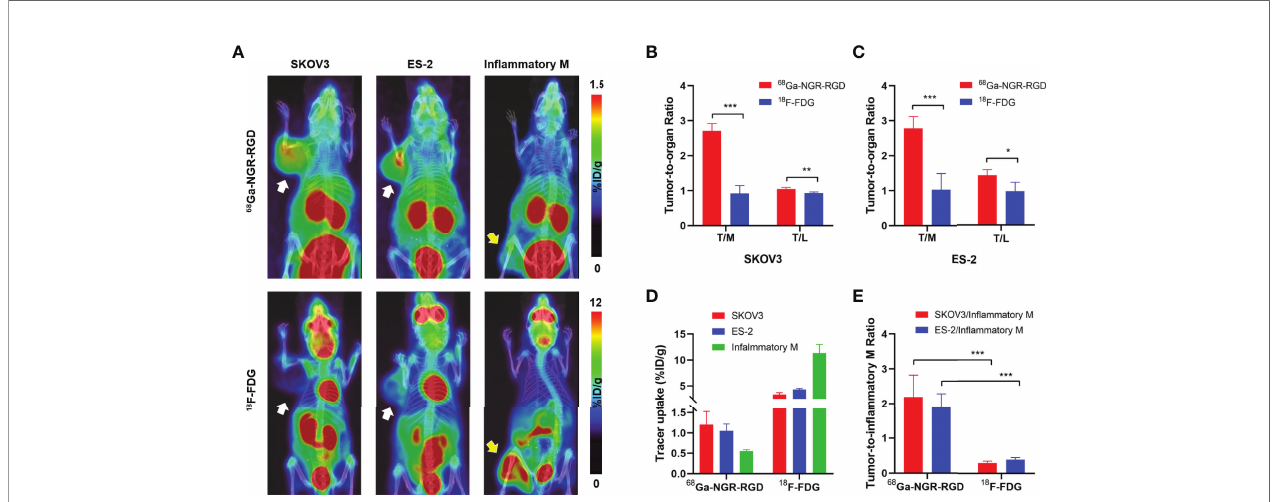
FIGURE 2 | PET/CT imaging and quantitative analysis of 68 Ga-NGR-RGD and 18 F-FDG in subcutaneous ovarian cancer models and in fl ammation models. (A) Representative static small PET/CT images of 68 Ga-NGR-RGD and 18 F-FDG in SKOV3 and ES-2 xenograft mice and turpentine oil-induced muscular in fl ammation mice at 1 h post radiotracer injection. White arrows indicated tumors and yellow arrows indicate the in fl ammatory muscles. (B, C) Tumor-to-muscle (T/M) and tumor-to-liver (T/L) ratios among 68 Ga-NGR-RGD and 18 F-FDG imaging in SKOV3 (B) and ES-2 (C) xenograft mice. (D) Quanti fi cation of 68 Ga-NGR- RGD and 18 F-FDG uptake in SKOV3 and ES-2 tumors and in fl ammatory muscle. (E) Tumor-to-in fl ammatory muscle (Tumor/In fl ammatory M) ratios. *p < 0.05, **p < 0.01, ***p < 0.001. Data are expressed as mean ± SD (n =